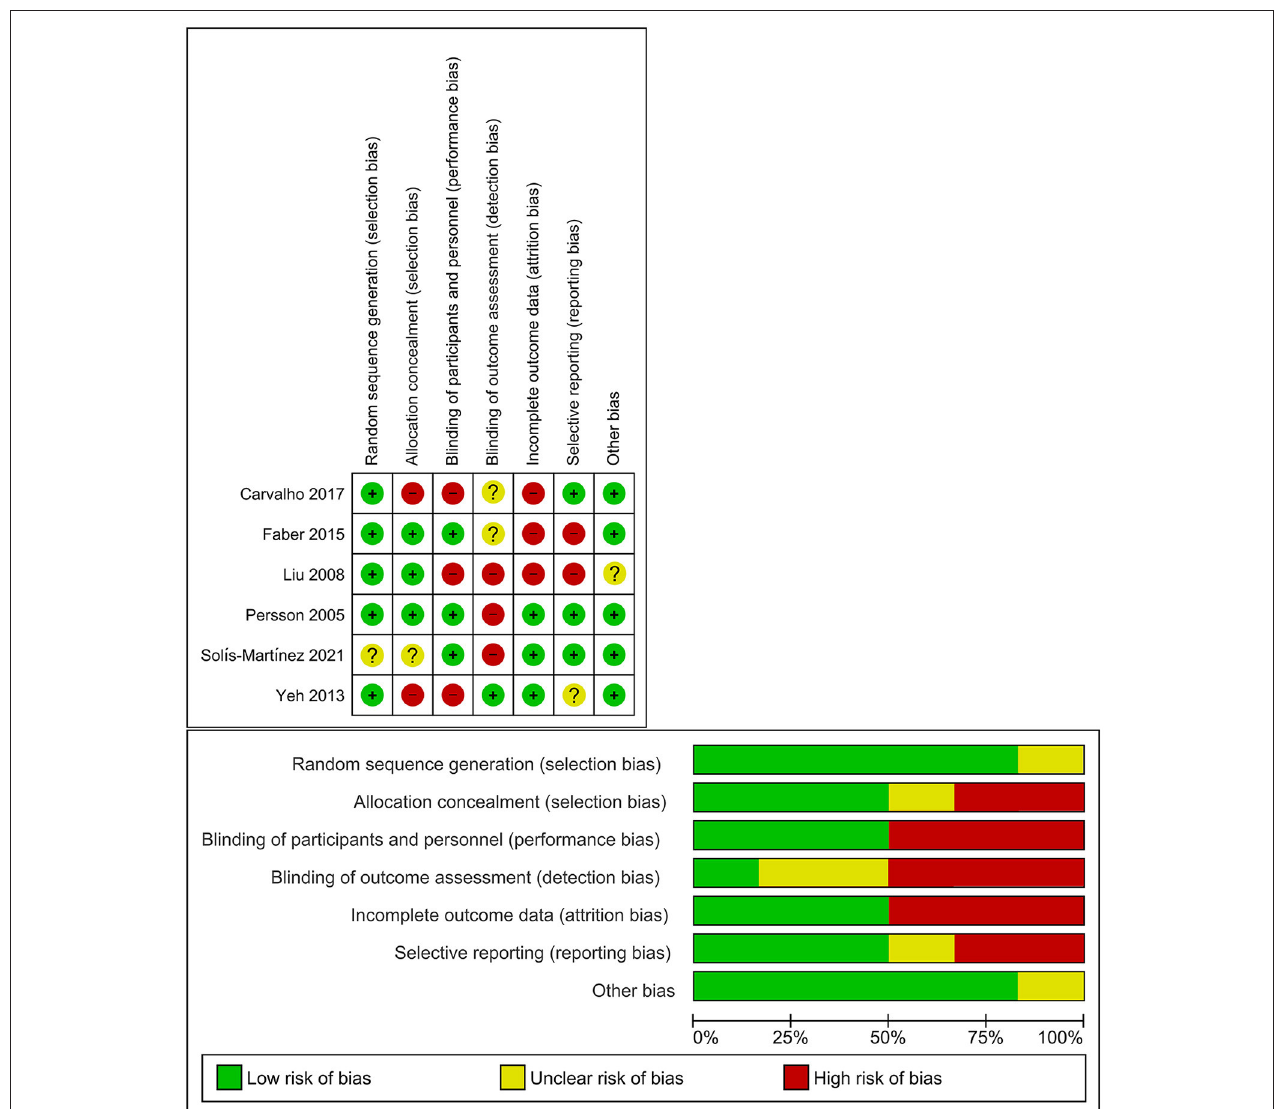
FIGURE 2 | Risk of bias from review authors’ judgments of each study and presented as a percentage across the included